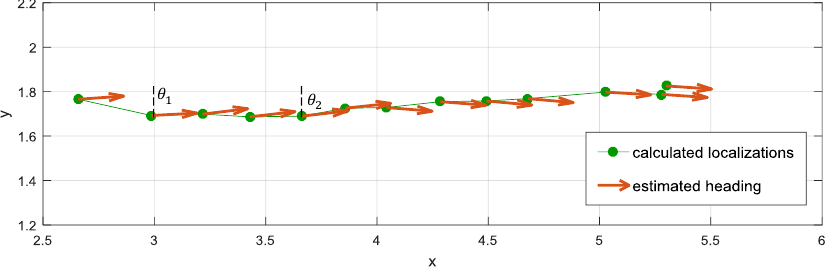
Figure 10. The illustration of heading estimation.